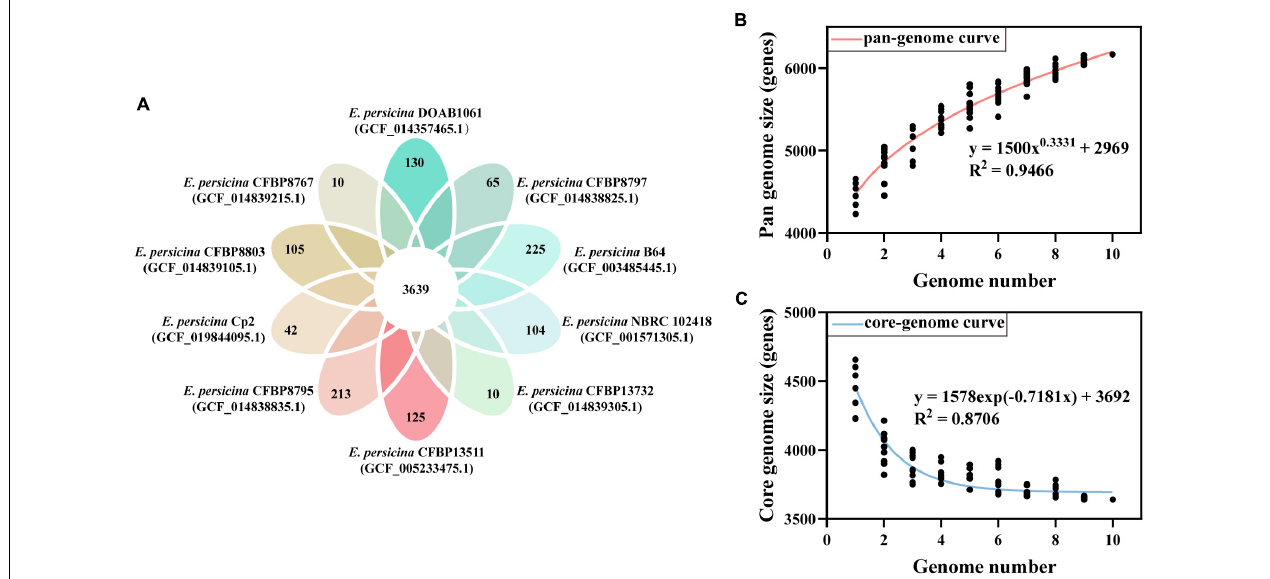
FIGURE 4 | Pan-genome and core-genome of E. persicina. (A) Petal diagram of homologous genes of E. persicina. The numbers of core genes in 10 E. persicina strains was represented in the center and strain-specific genes in the petals. Latest RefSeq assembly accession numbers for each strain is presented in parentheses. (B) Pan-genome plot of E. persicina. The curve, fitted by the power-law regression model, represents the relationship between the number of genome and pan-genome size. (C) Core-genome plot of E. persicina. The curve, fitted by exponential curve fit model, indicates the number of core-genome as a function of the number of sequentially added